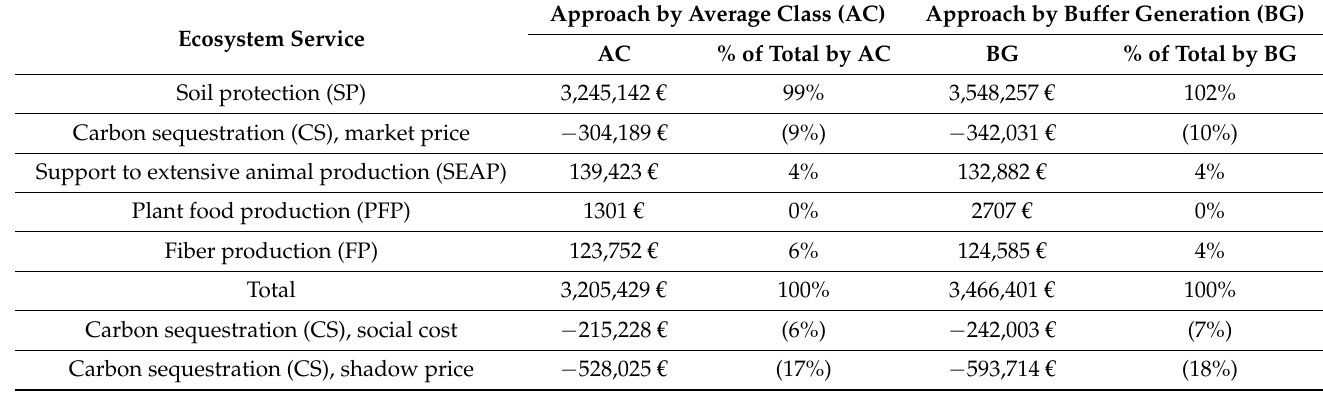
Table 4. Total ecosystem services value for all farms in the dataset on aggregate, using the class (AC) and buffer (BG) approaches.